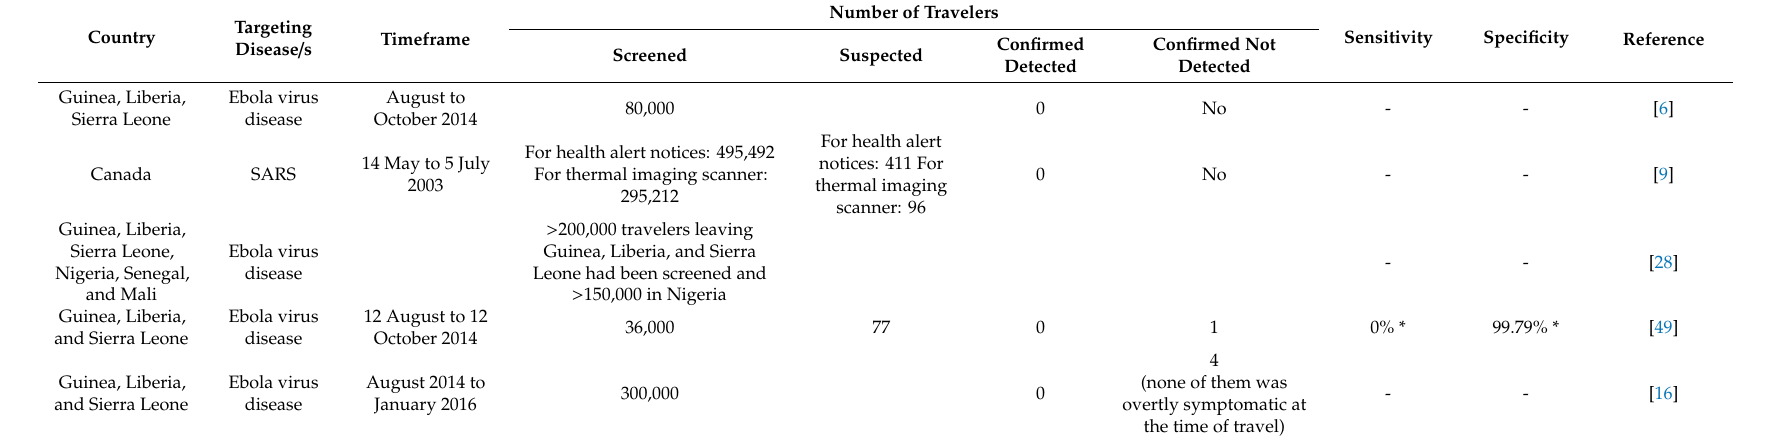
Table 8. Number of travelers screened, suspected and confirmed cases identified through exit screening.